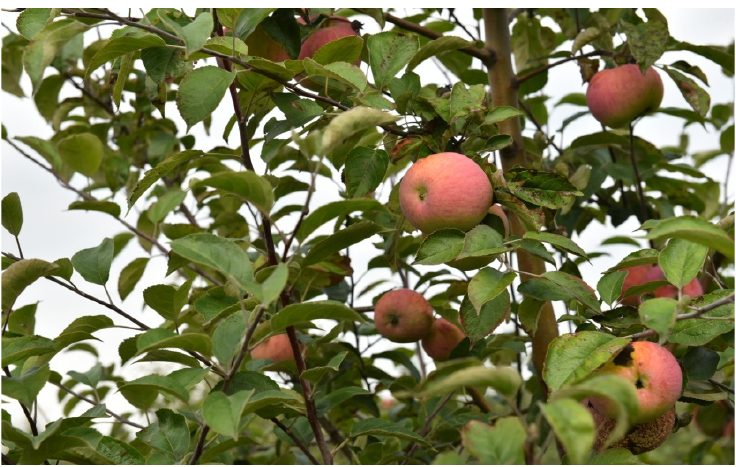
Figure 2. Image of apples for training.